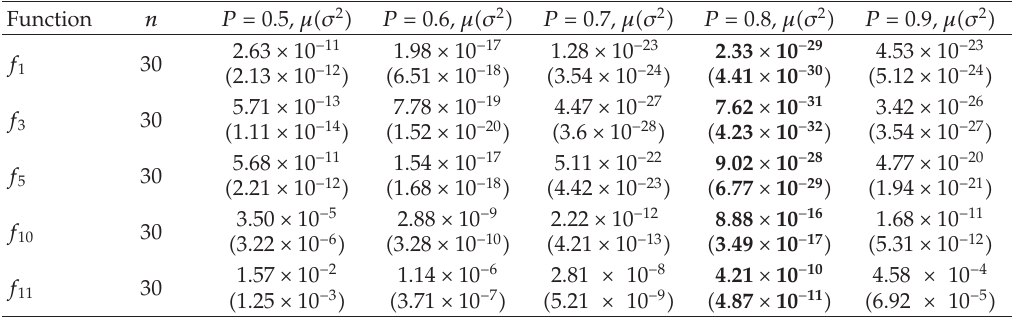
Table 1: Results of CAB with variant values of parameter P over 5 typical functions, with H (cid:8) 0 . 8. Function